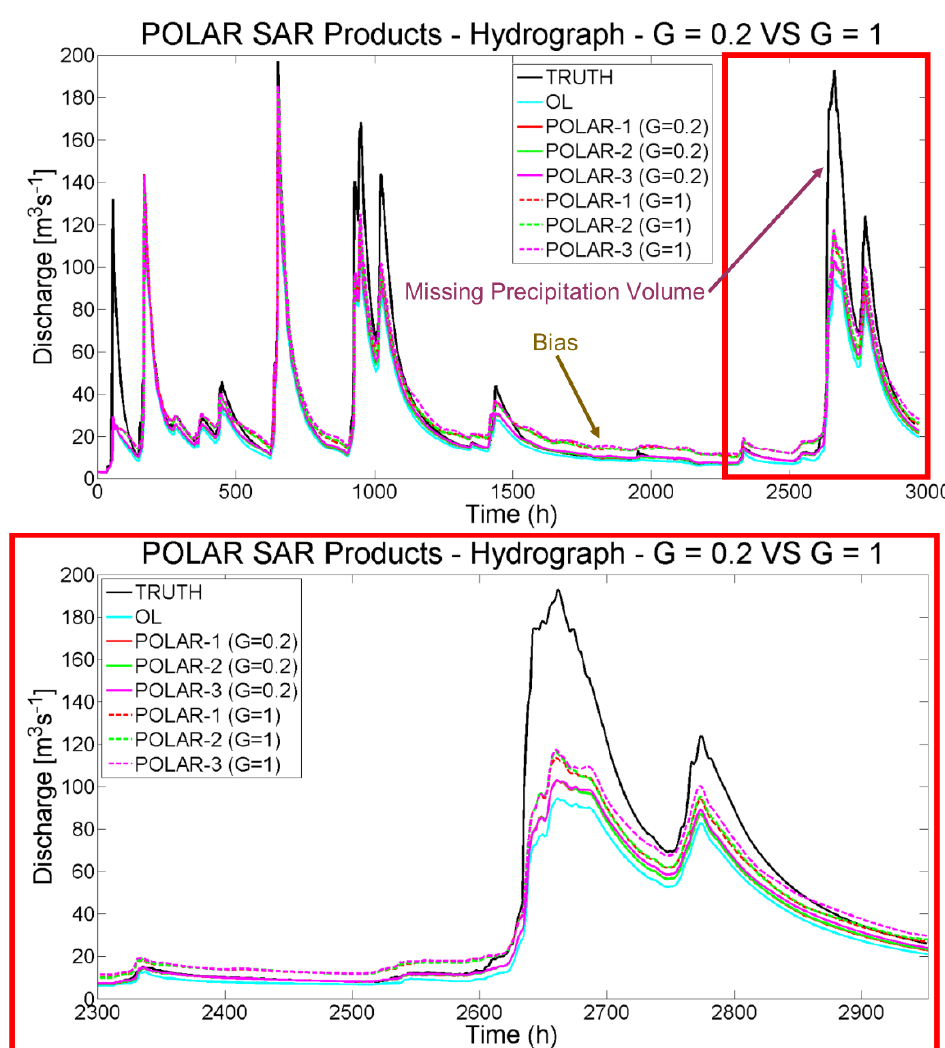
Figure 11. Comparison of discharge data generated by the OL run (i.e., G = 0), and the data generated by assimilating POLAR SAR-like SM products with G values equal to 0.2 and 1. The figure also highlights: (i) the error produced by the missing precipitation volume (which originates an underestimation of the streamflow simulation with respect to that produced by the TRUTH run); (ii) the bias affecting the discharge obtained by the model after SM-DA with G = 1.